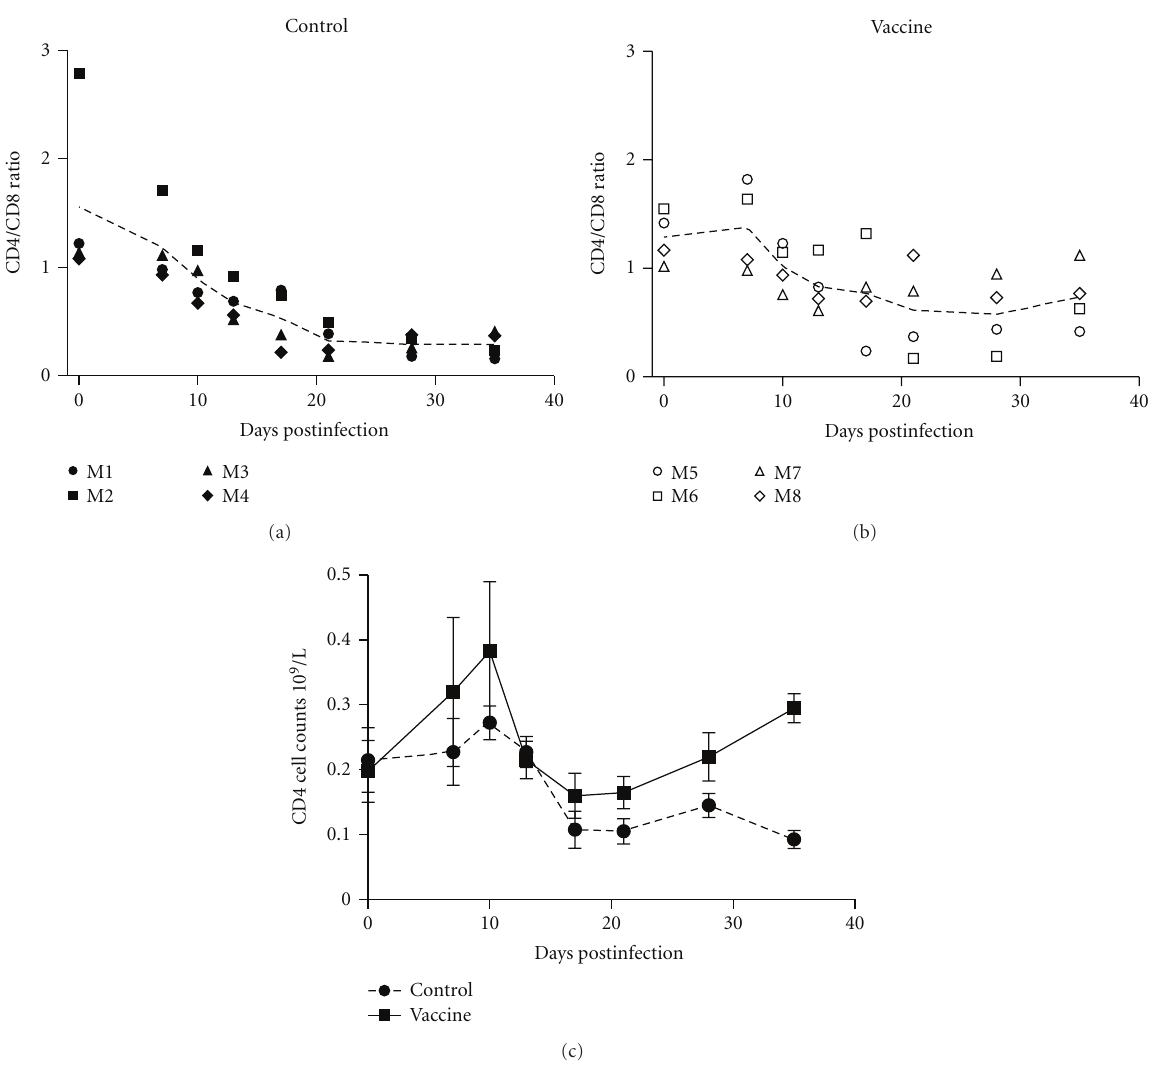
Figure 5: CD4/CD8 ratio analysis and total CD4 counts post-SHIV-KB9